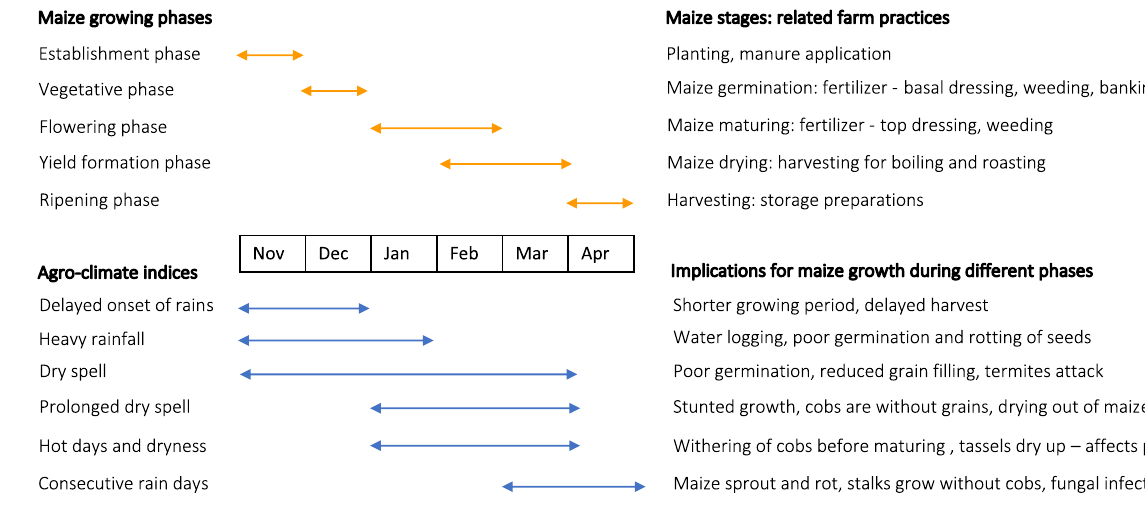
buying the right seed variety and other necessary inputs such as fertilizers, and budgeting for the